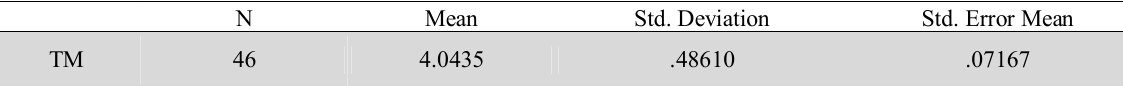
The summary of some basic statistics